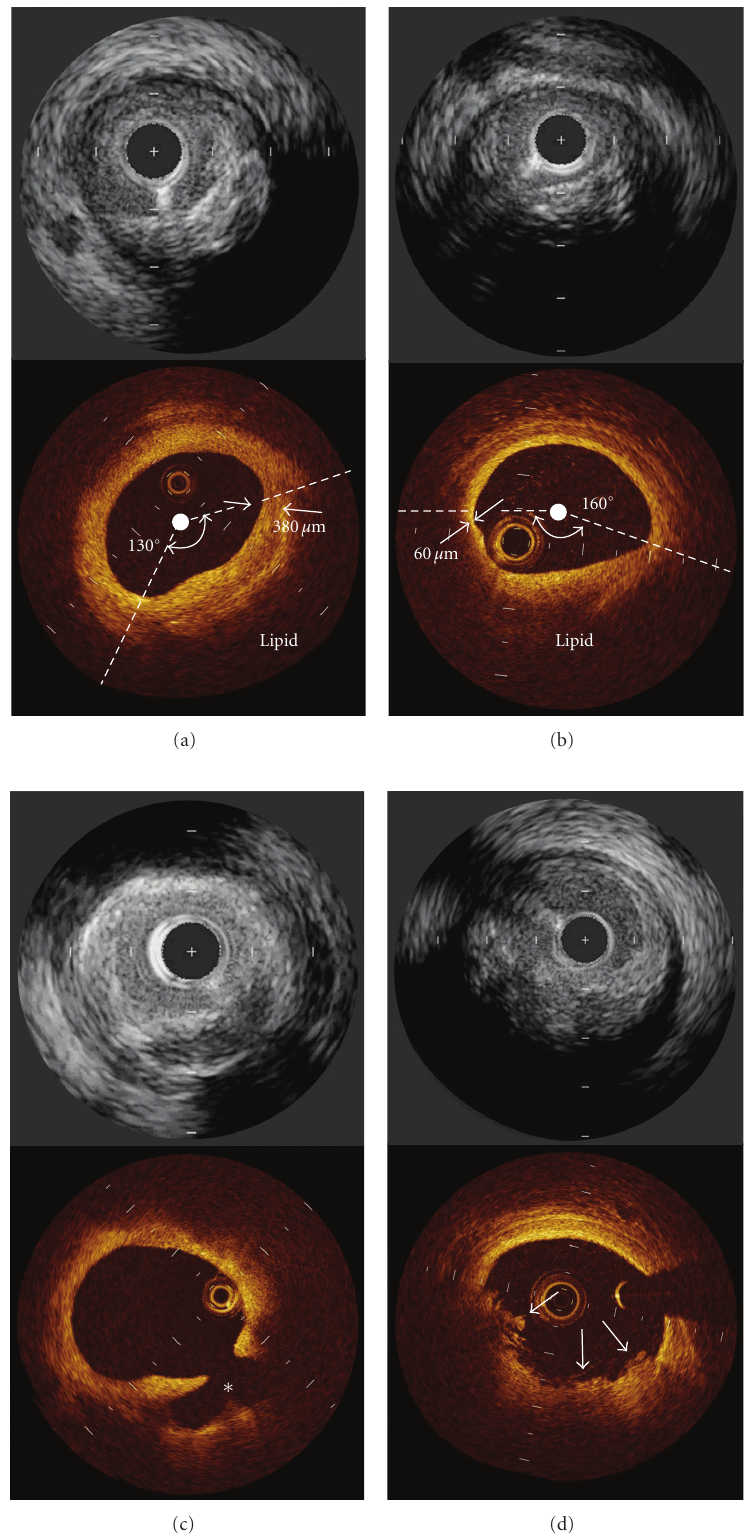
Figure 1: IVUS images of attenuated plaques and corresponding OCT images. OCT revealed that IVUS-detected attenuated plaques include (a) lipidic plaque with fibrous cap of 380 μ m thick and lipid arc of 130 degree, (b) thin-cap fibroatheroma with fibrous cap of 60 μ m thick and lipid arc of 160 degree, (c) plaque rupture ( ∗ ), and (d) mural thrombi